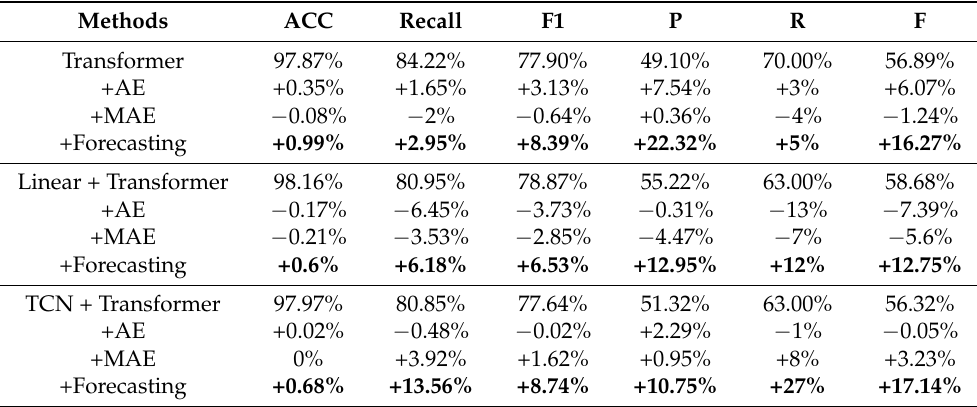
Table 6. Ablation experiment on SSL pretraining task.